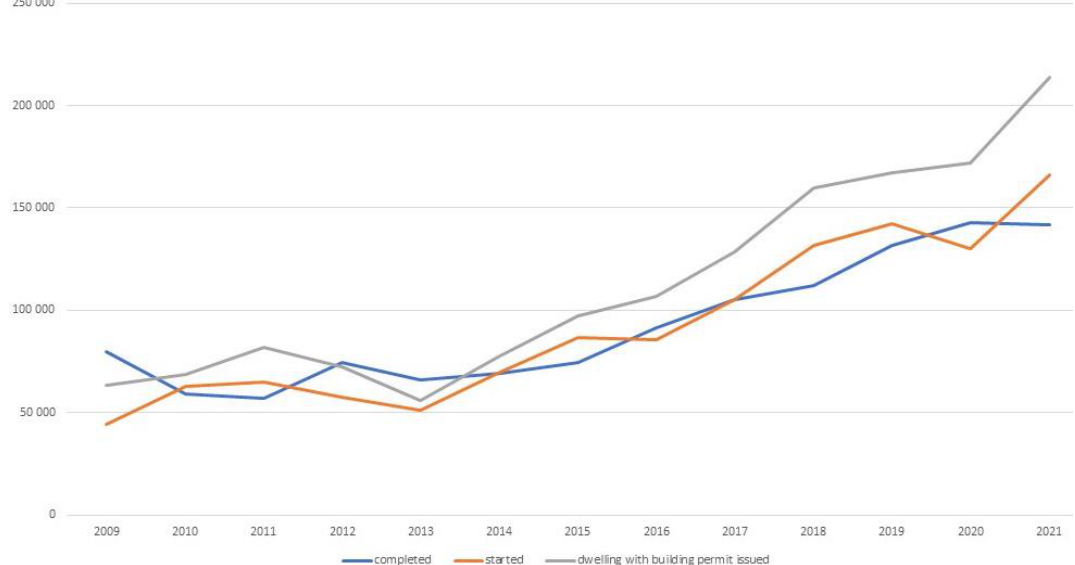
Fig. 5. Number of developers’ dwellings started and completed, and those for which a building permit was issued in Łódź in Poland between 2009–2021 (Own study based on LDB)